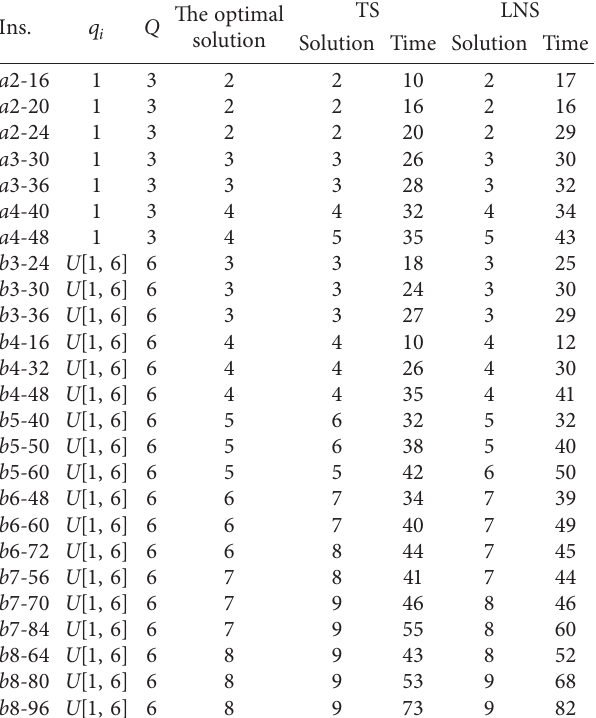
Table 4: Summary of results on different scale instances.